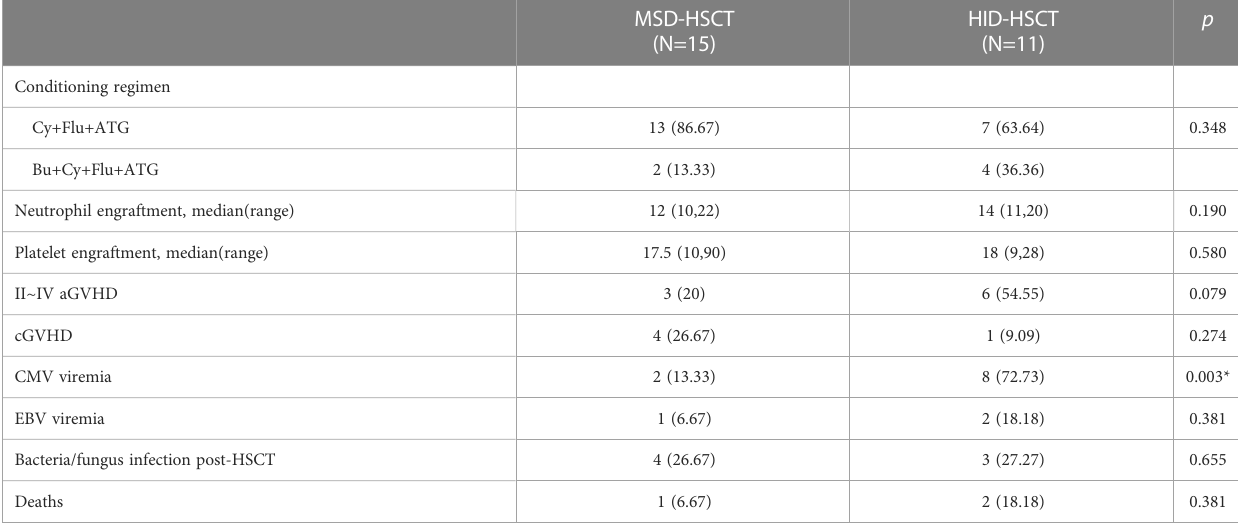
TABLE 4 Comparison of characteristics and treatment outcome between MSD-HSCT and Alternative donor